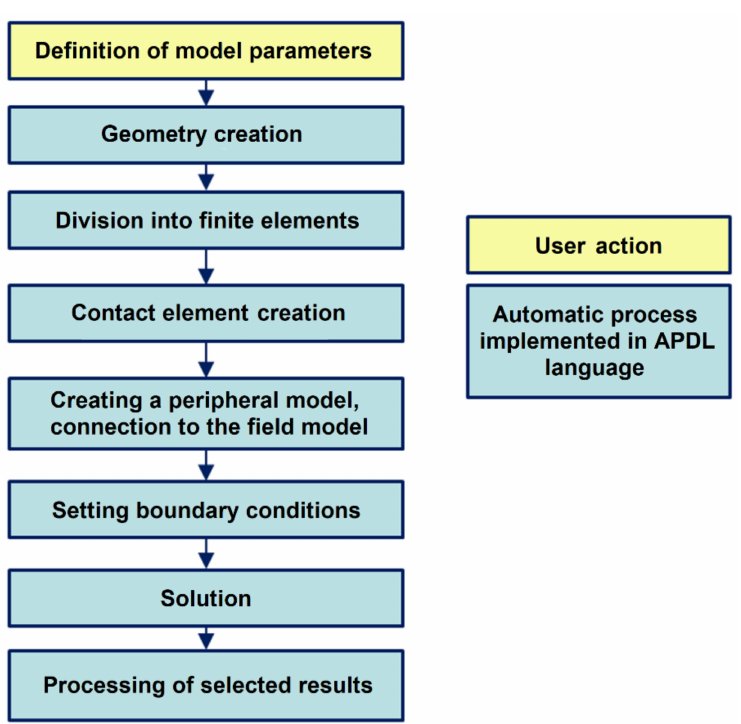
Figure 8. Individual stages of creating a numerical model.